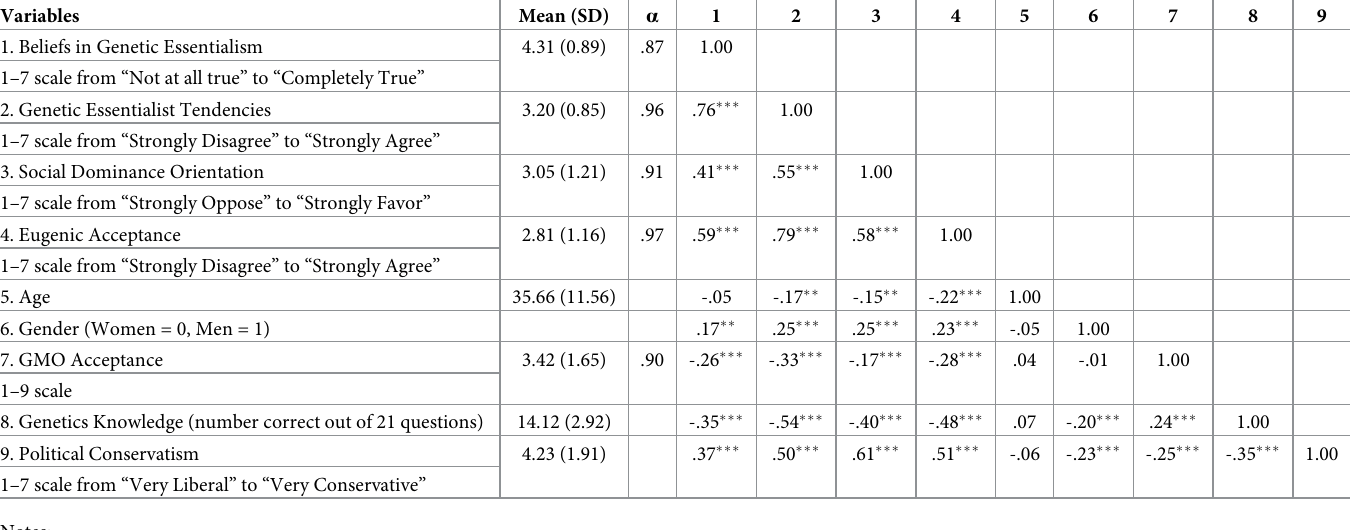
Table 2. Mean, alphas, and bivariate correlations for all variables in Study 2.